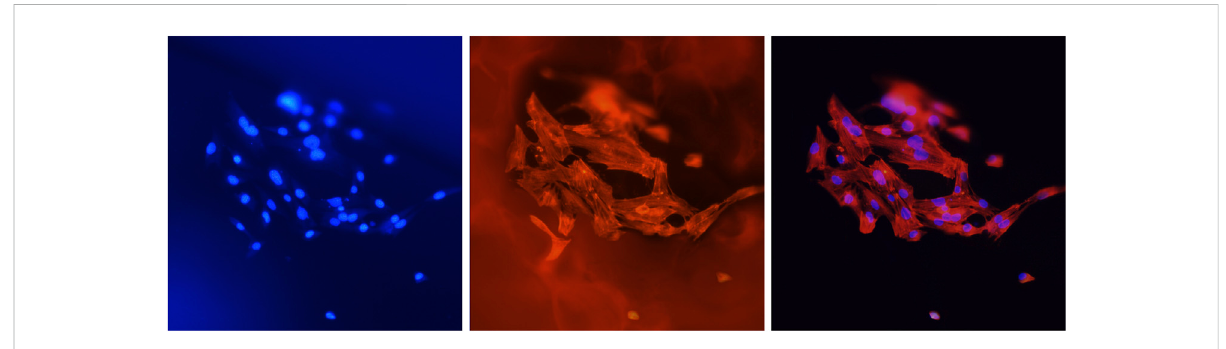
FIGURE 7 Cells (MC3T3-E1) attached to the scaffolds. Blue fl uorescence shows the nuclei stained with DAPI, and red fl uorescence shows the cellular F-actin stained with FITC-phalloidin. The magni fi cation was